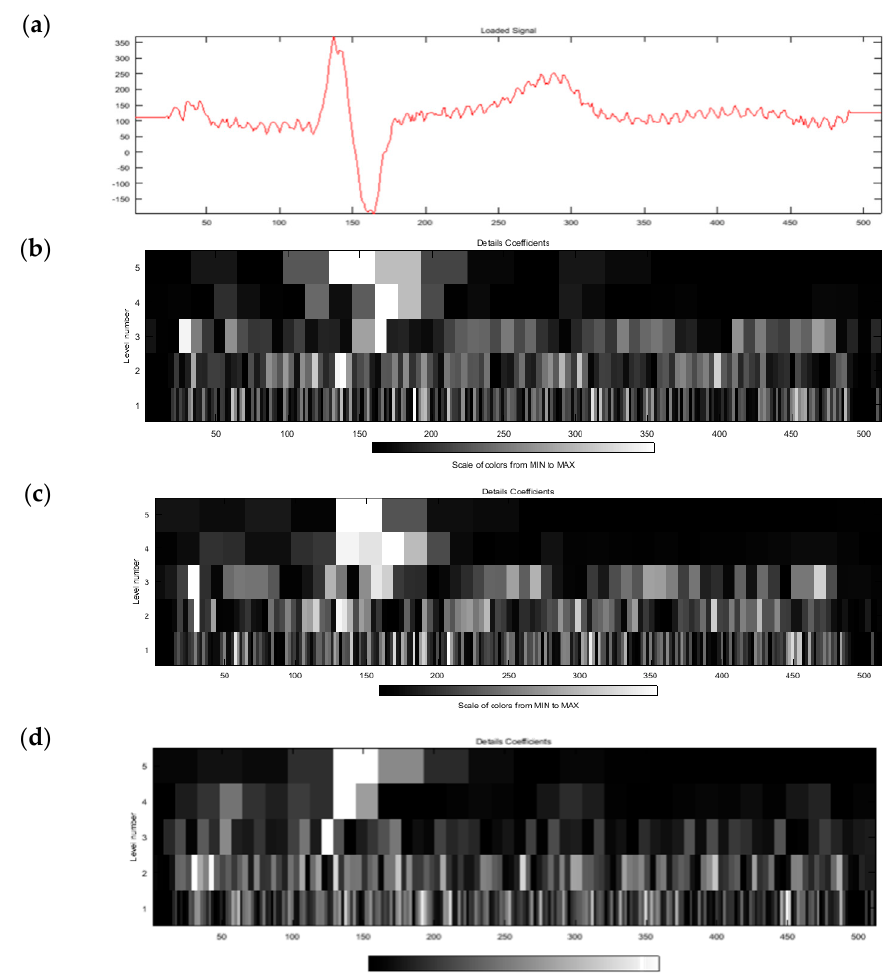
Figure 5. Difference of time-frequency representation with use of different wavelets (example of CSE MA001). ( a ) clean carrier; ( b ) time-frequency representation with db5 wavelet; ( c ) time-frequency representation with db10 wavelet; ( d ) difference between time-frequency representations with db5 and db10 wavelets. Table 2. Watermarking performance with use of different wavelets (40 iterations for 4 intervals, coding bit depth from 1 to 5 and textual or numerical